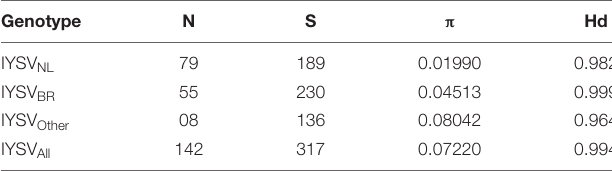
TABLE 2 | Genetic diversity test of Iris yellow spot orthotospovirus genotypes.